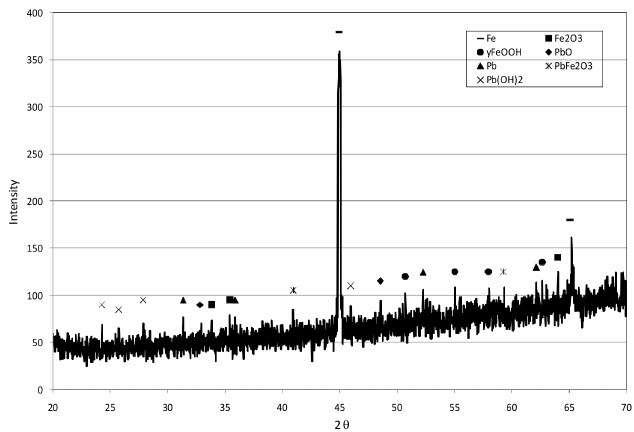
Figure 14. XRD diffractogram of mZVI after the test conducted with Pb 2+ concentration of 70 mg/L and initial pH =